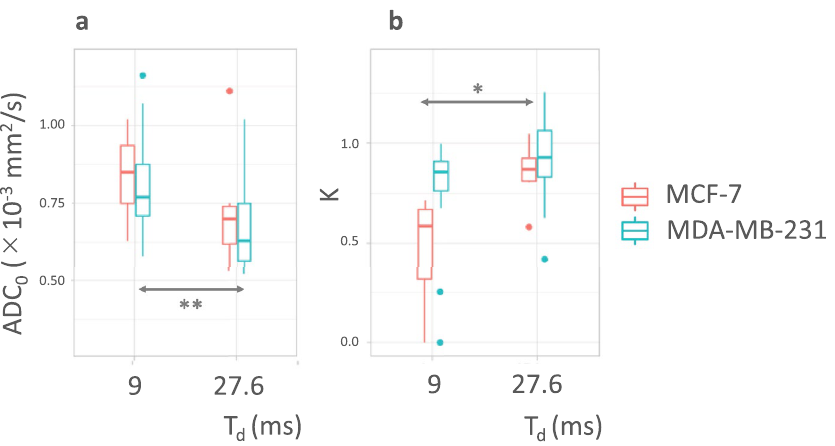
Figure 2. Box-whisker plots of ( a ) ADC 0 and ( b ) K parameters against diffusion time. * P < 0.05, ** P < 0.01. ADC 0 in the MDA-MB-231 group decreased significantly ( P < 0.01), and ADC 0 in MCF-7 group decreased ( P = 0.16), with increased diffusion time. K in the MCF-7 group increased significantly ( P < 0.05) and K in the MDA-MB-231 group increased ( P = 0.06) with increased diffusion time.